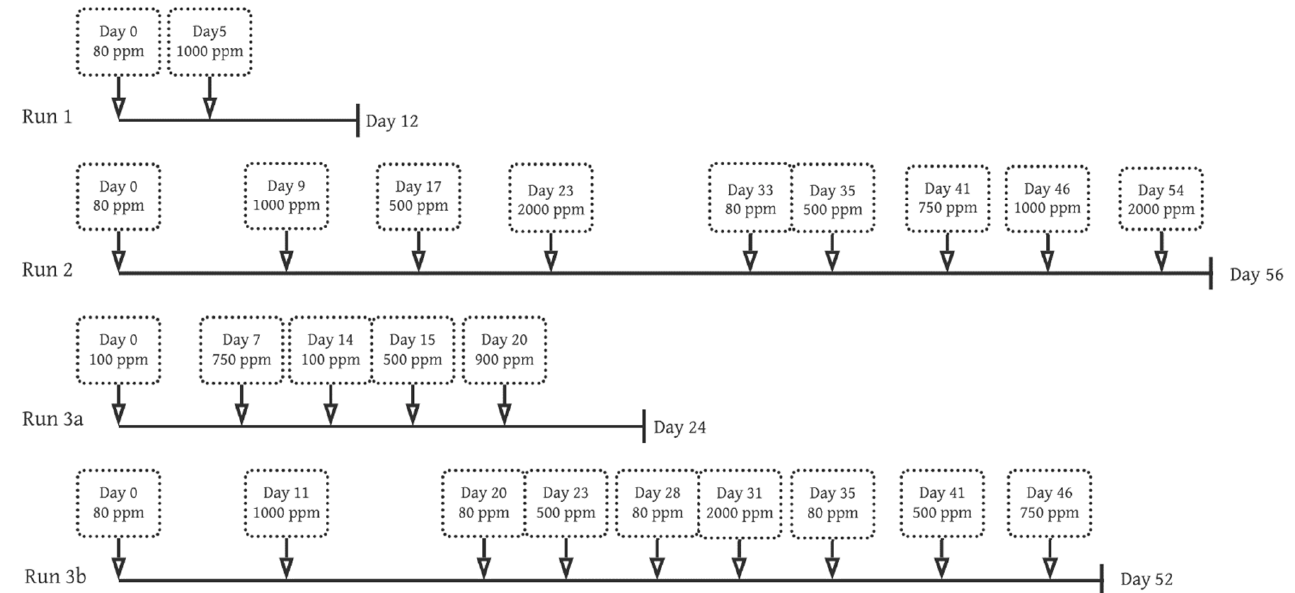
Figure 1. Experimental timeline and loading conditions for each run.